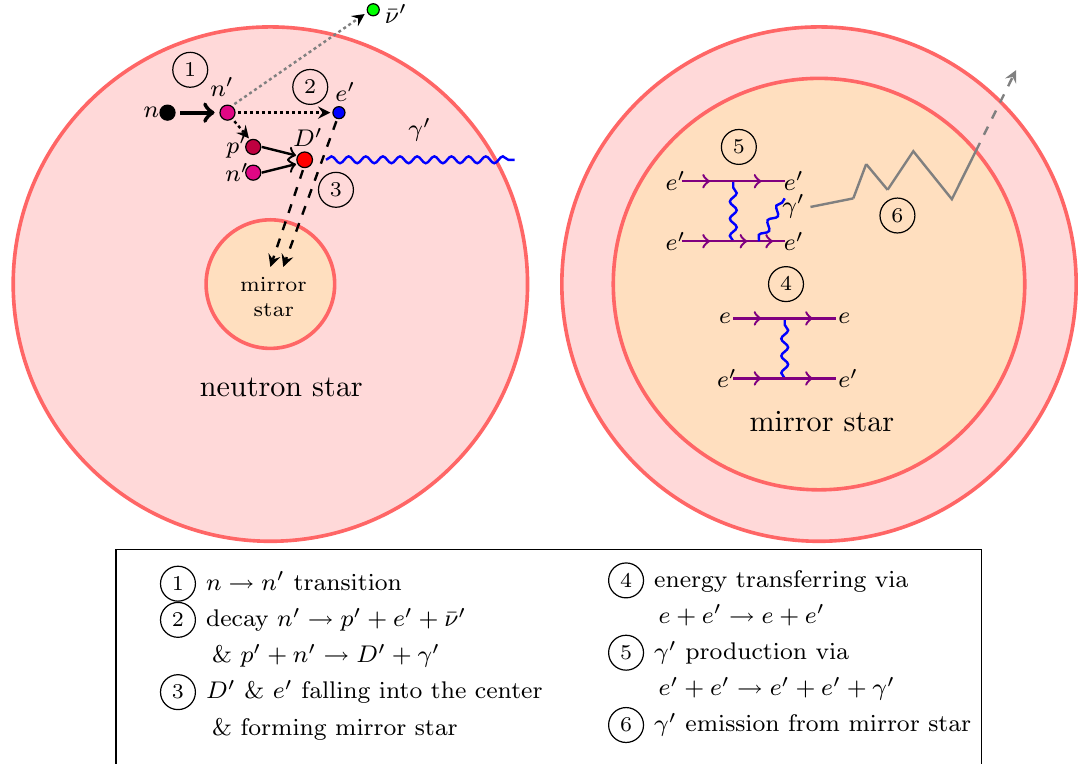
Fig. 1 A schematic depiction of what happens after the n − n (cid:2) transition takes place in a NS. The formation of heavier nuclei such as 4 shown in this figure, which will not affect the main results in this paper. In the right panel we zoom in the “mirror star” region in the left